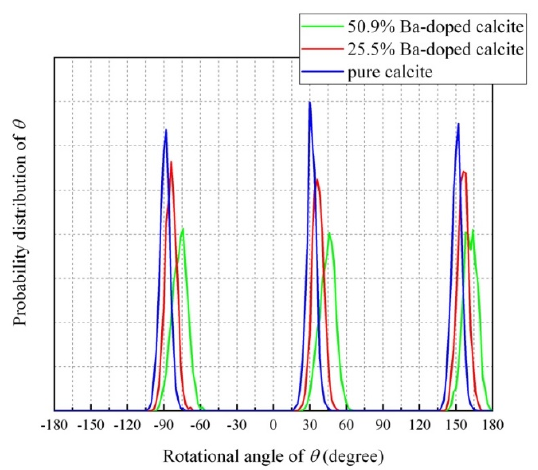
Figure 8. Probability distributions of rotation angle ( θ ) of one CO 3 2 − ion between the C–O bonds and the a -axis for CaCO 3 , Ca 0.5 Ba 0.5 CO 3 , and Ca 0.5 Ba 0.5 CO 3 at 300 K.